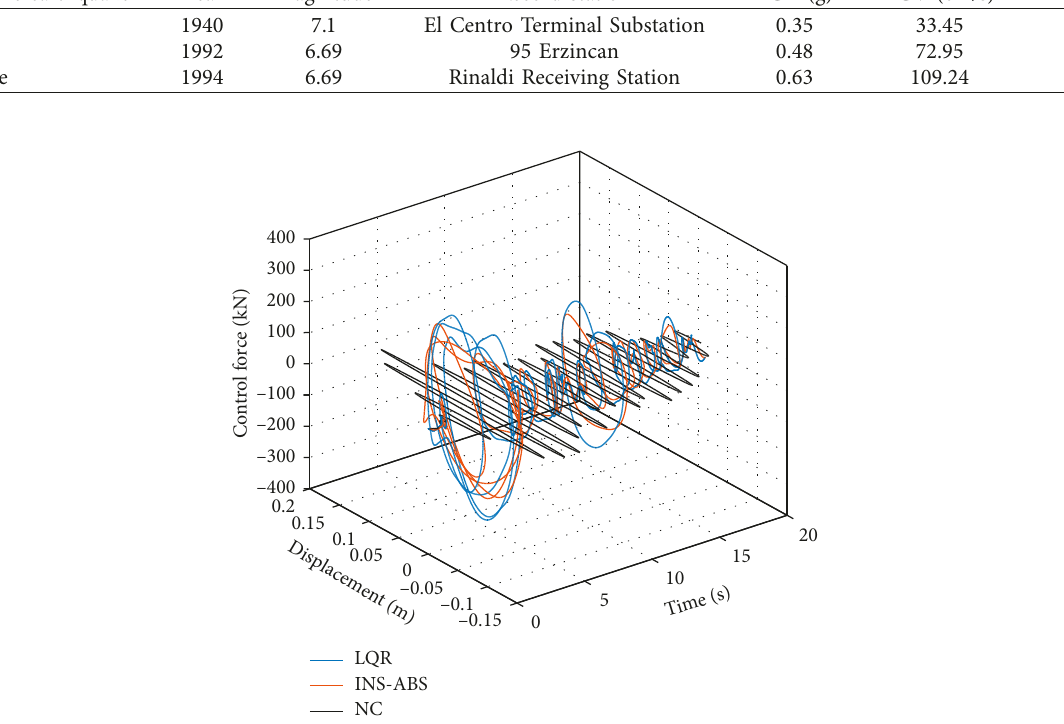
Figure 3: Top story displacement and control forces for El Centro earthquake. Table 2: Comparison measures for El Centro earthquake.